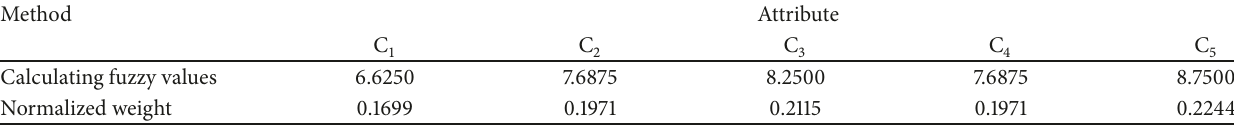
Table 5: Fuzzy values of set fuzzy weights and normalized weights of attributes.